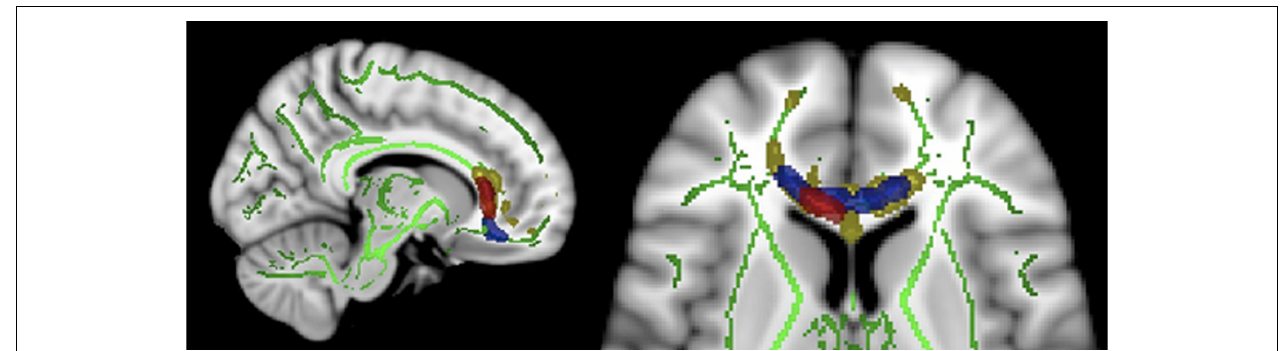
FIGURE 1 | Sagittal and axial views of Tract-Based Spatial Statistics results (MNI coordinates mm: x = 11 and z = 7 respectively). Green : mean FA (fractional anisotropy) skeleton. Yellow : higher correlation of FA values between monozygotic twin pairs compared to randomly generated pairs. Blue : reduced